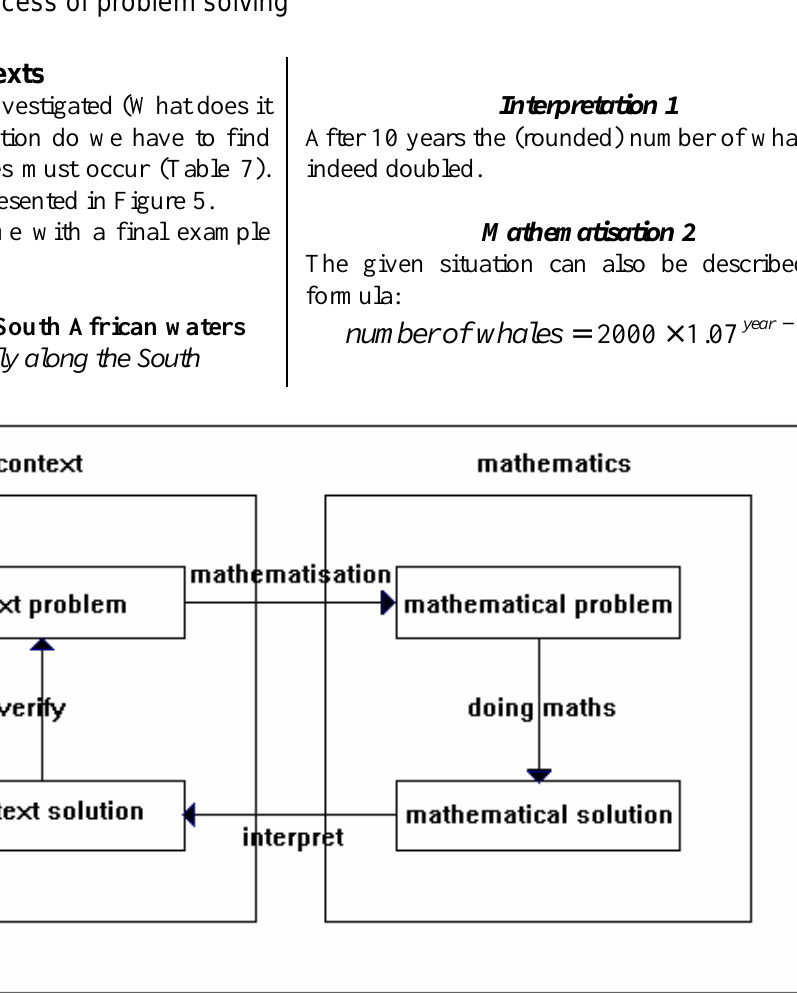
Figure 5. Scheme of learning mathematics in a